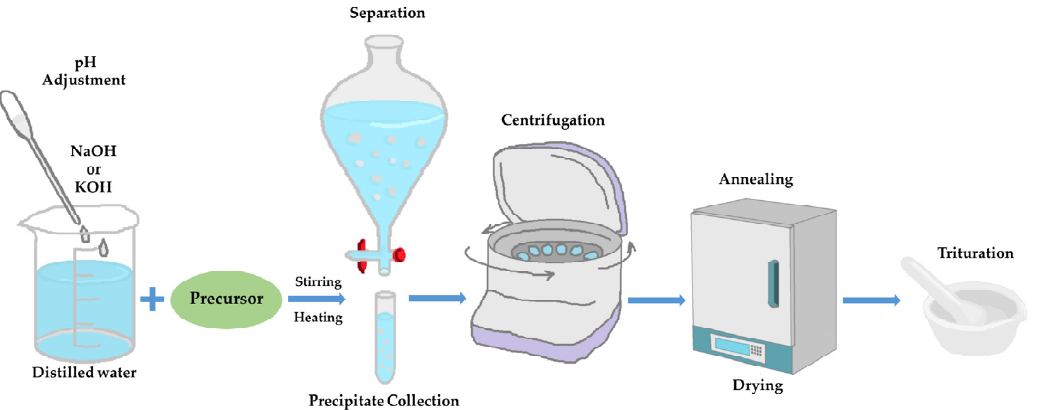
Figure 1. Synthesis process schematic representation. Each procedure is being separately described below.